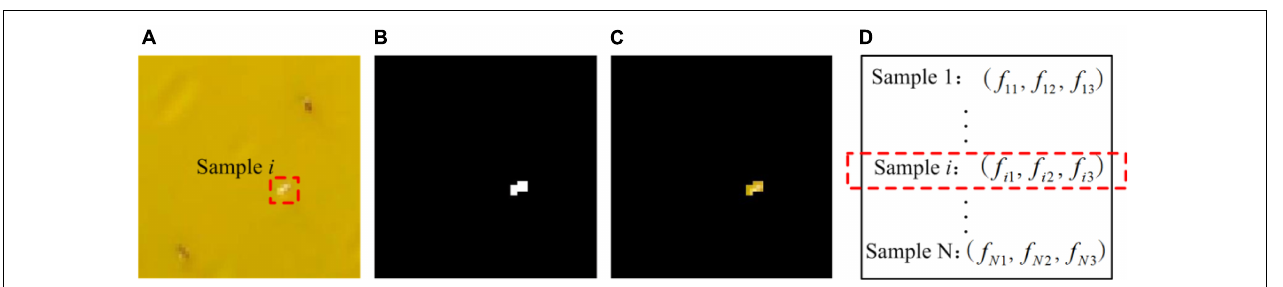
FIGURE 7 | Images documenting feature extraction of individual insects. (A) Sub-block image, (B) a detected region, (C) an isolated insect, (D) feature vector in color